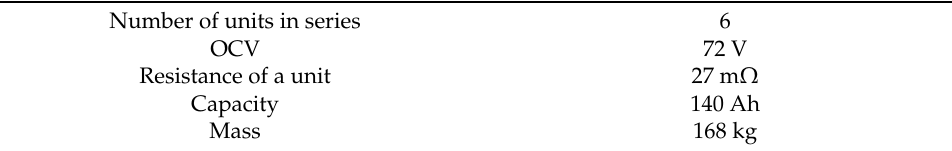
Table 1. Characteristics of the considered battery